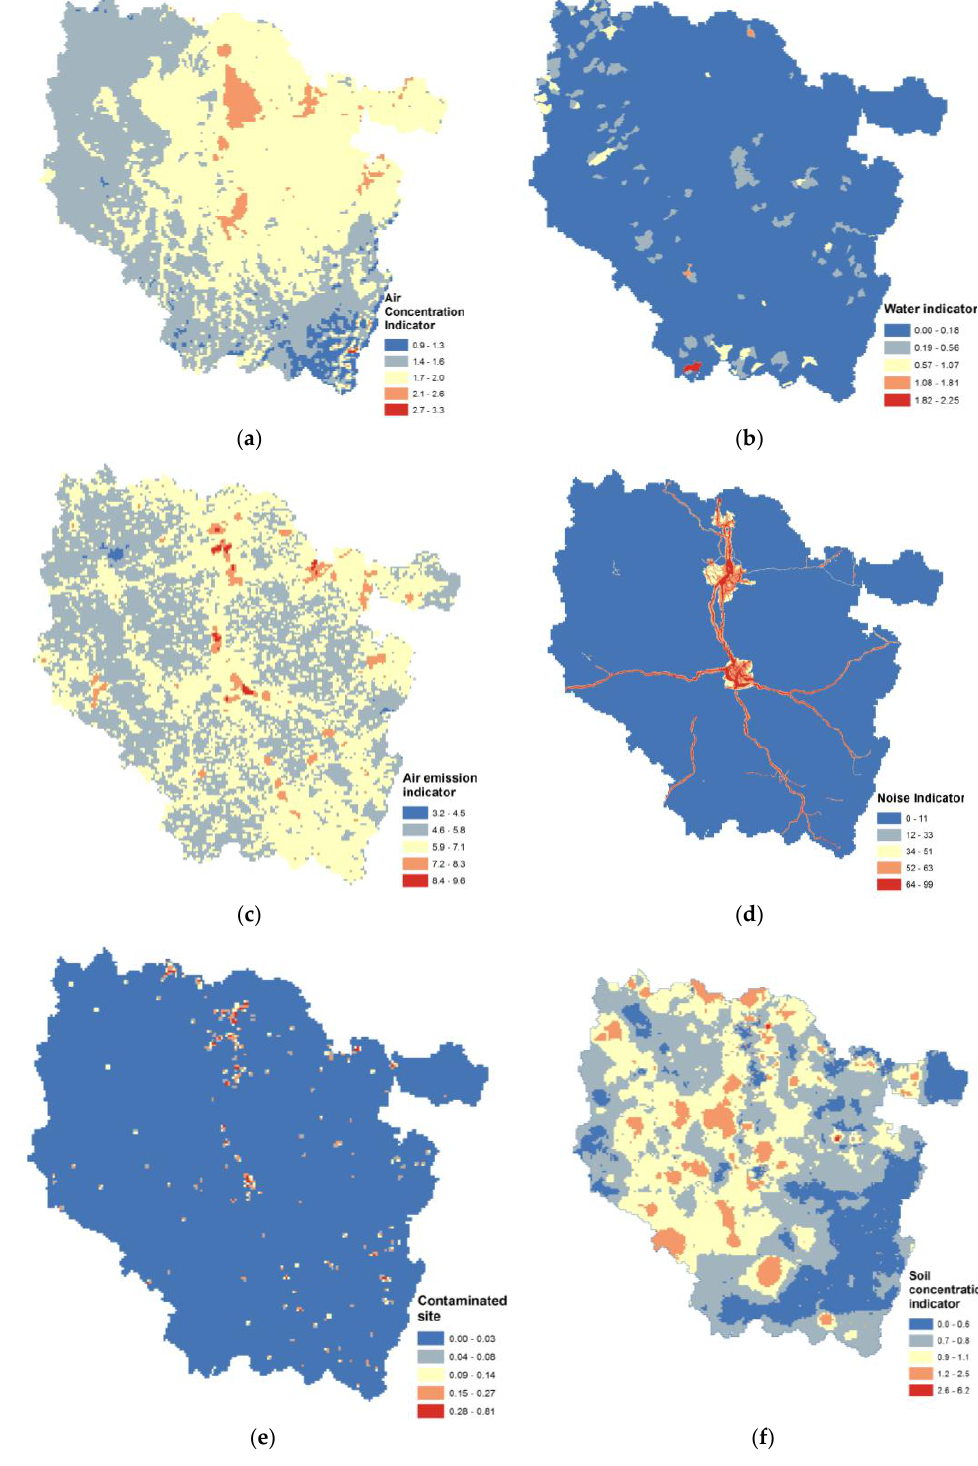
Figure 2. Maps of exposure variables for: ( a ) air concentration; ( b ) water exposure hotspots; ( c ) air emissions; ( d ) LDen noise; ( e ) potential site and soil contamination; and ( f ) soil concentration. Maps of the combined exposure variable indicators for air and soil are presented in Figure 3.